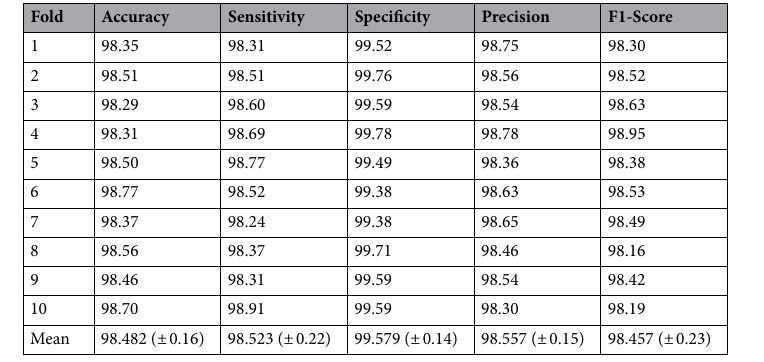
Table 6. Results of tenfold cross-validation using non-augmented dataset.